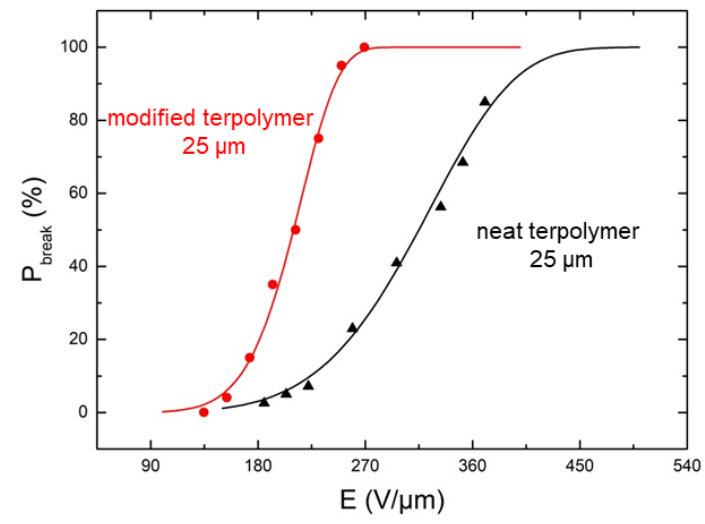
Figure 5. Breakdown probability versus electric field for different electrostrictive composites.